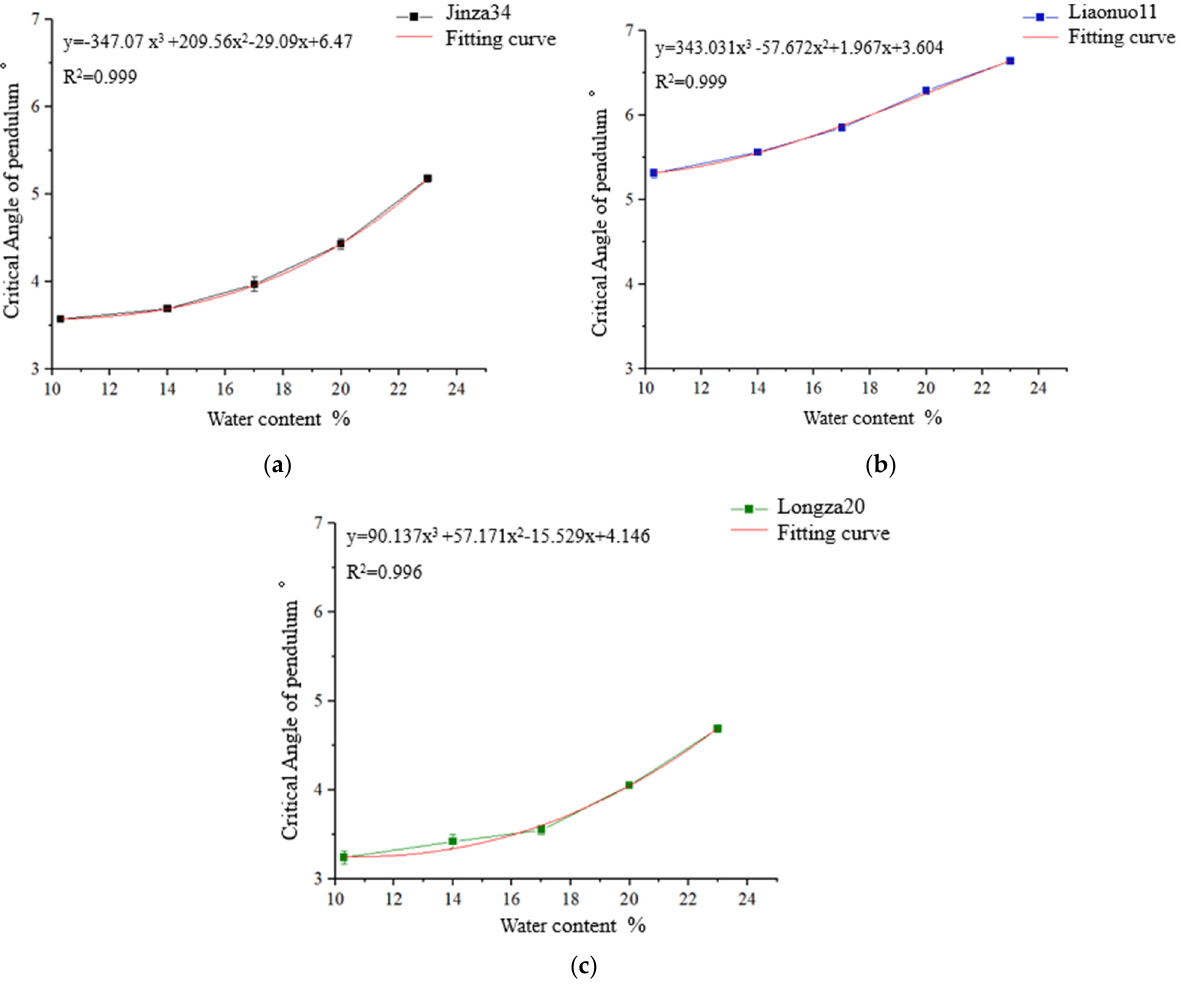
Figure 12. Critical angle of the pendulum for the impact mechanics tests of different varieties of sorghum seeds. ( a ) Jinza34. ( b ) Liaonuo11. ( c ) Longza20. sorghum seeds. ( a ) Jinza34. ( b ) Liaonuo11. ( c )